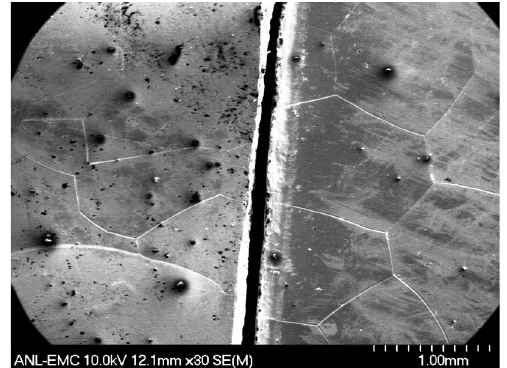
FIG. 9. SEM image of bent (left) and unbent (right) foils. Bent foil shows higher density of dark patches.